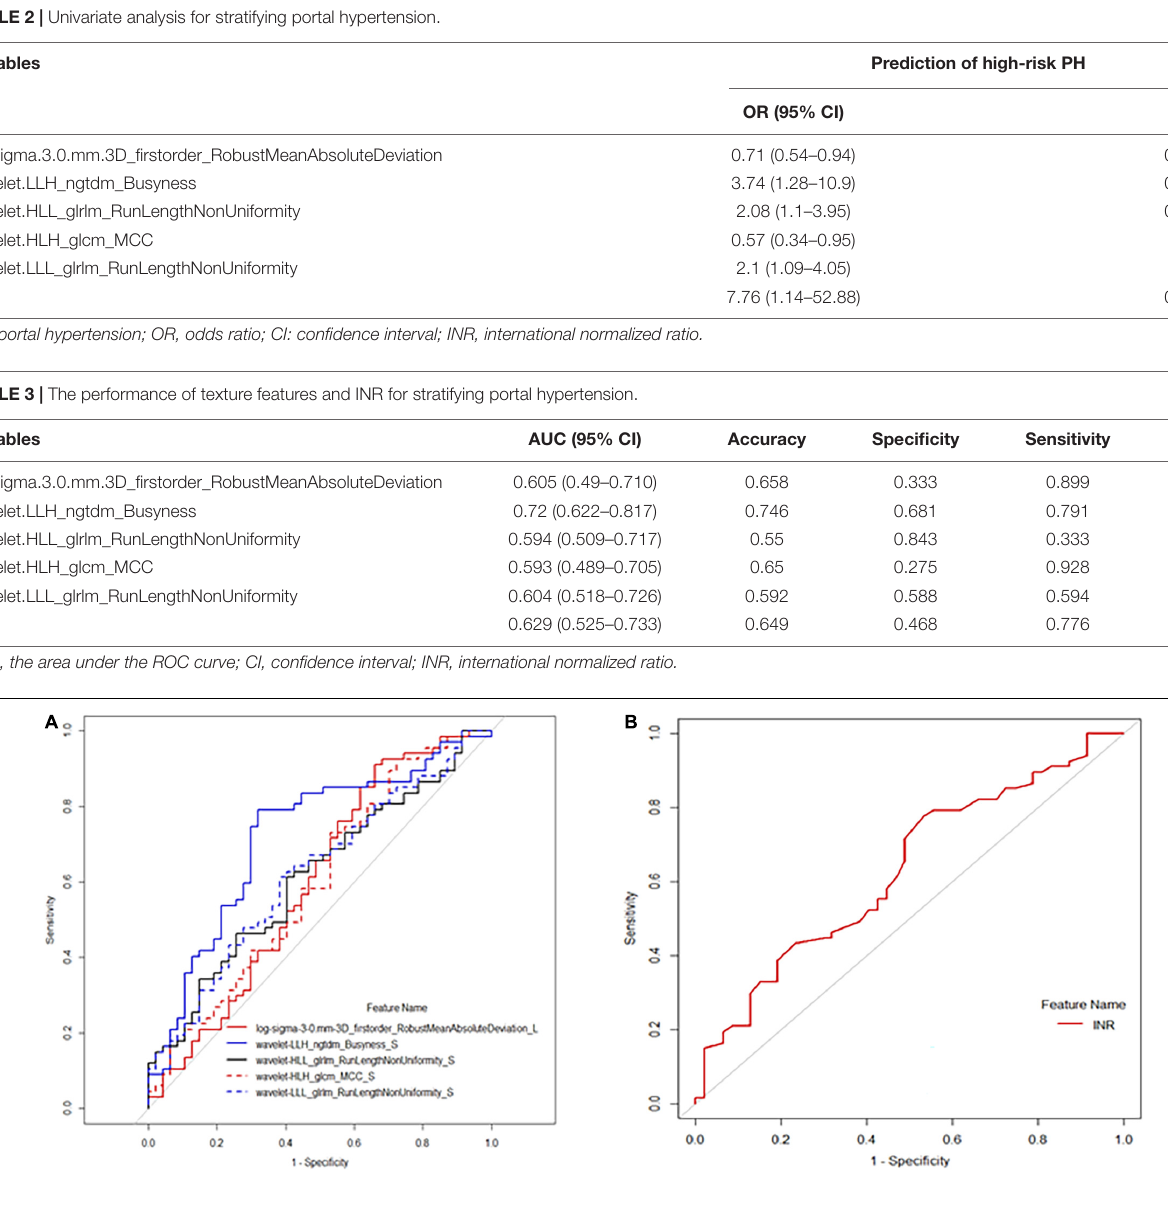
FIGURE 3 | Receiver operating characteristic (ROC) analysis of selected texture .features and international normalized ratio (INR) for predicting high-risk portal hypertension (PH). (A) The ROC curve calculated by texture features of